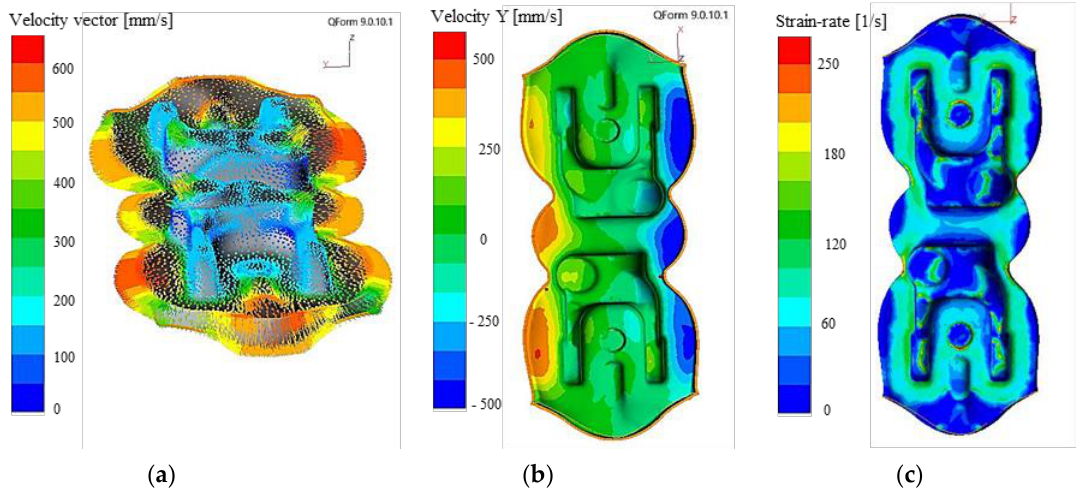
( b ) Figure 12. Results of analysis with the use of numerical modelling: ( a ) course of forging forces in the function of displace- ment in the horizontal direction in axis X, ( b ) in the horizontal direction in axis Y. Also, the vectors of the material’s displacement rates in the roughing operation were analyzed, where the material deformation is the most significant. The analysis showed a high coefficient oscillating around the values of about 500 mm/s near the forging’s arms, with a tendency for clockwise twisting (Figure 13a). After the analysis of the flow rate between the sides of the forging (Figure 13a), we can observe a difference at the level of 50–80 mm/s, which implies a tendency for unidirectional elastic rotation of the upper tools